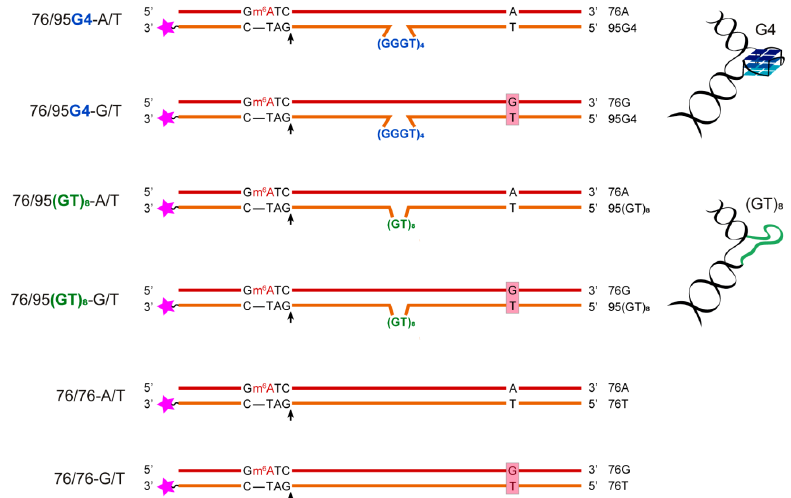
Figure 1. The DNA models applied to study the interactions of a G4 with MMR proteins. The DNA sequences are presented in the Supplementary Materials. The names of DNA duplexes are shown on the left, and the names of the single-stranded oligonucleotides are presented on the right. The 5 ′ - Gm 6 ATC-3 ′ /3 ′ -CTAG-5 ′ sequence corresponds to a site recognized by MutH, where m 6 A stands for N 6 - methyl -2’- deoxyadenosine, and black arrows indicate the position of DNA hydrolysis by the MutH endonuclease. Pink asterisks represent the 5-carboxytetramethylrhodamine (TAMRA) fluorophore for DNA labeling.